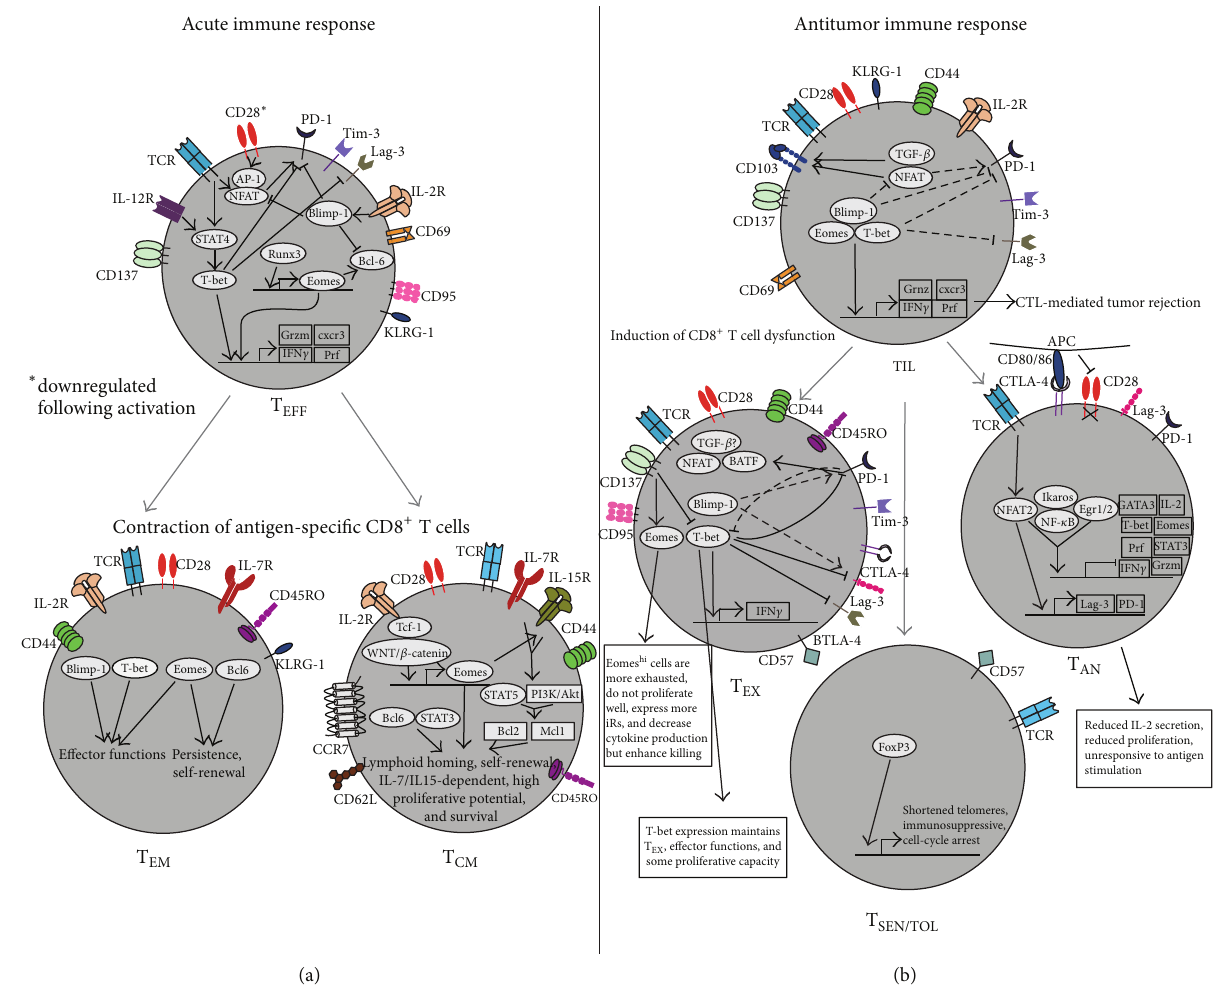
Figure 1: Characterization of CD8 + T cell fates in acute and antitumor immune responses. (a) In an acute immune response, CD8 + T cell regulated by the transcription factors T-bet, Runx3, Eomes, Blimp-1, and NFAT and the cytokines IL-2 and priming induces cytotoxic T EFF contract into T and T . T are regulated by different levels of T-bet/Eomes and Blimp-1/Bcl- IL-12. Following antigen clearance, T EFF EM CM EM have higher levels of Eomes and Bcl-6 as compared to T and are influenced by expression of Tcf-1, WNT/ 𝛽 -catenin, STAT3, and 6. T CM EM with high proliferative potential. IL-7 and IL-15 maintain homeostatic STAT5, which cooperate to maintain a persistent population of T CM traffic to tumors as TILs. T-bet and Blimp-1 cooperate to repress iR proliferation of CD8 + memory T cells. (b) Tumor antigen primed T EFF expression and, with Eomes, promote CTL-mediated tumor rejection. NFAT and TGF- 𝛽 promote tumor cell lysis through CD103 expression. , T , or T . High T-bet expression maintains functional T whereas high Eomes expression Dysfunctional TIL can become T EX AN SEN / TOL EX . T result from insufficient costimulation promotes severe exhaustion. There is complex interplay between T-bet, Blimp-1, and iRs in T EX AN through CD28. Unbalanced NFAT signaling induces anergy-inducing genes and, along with Ikaros, Egr1/2, and NF- 𝜅 B, inhibits effector lack CD28 expression and may be regulated by molecule expression. T SEN / TOL